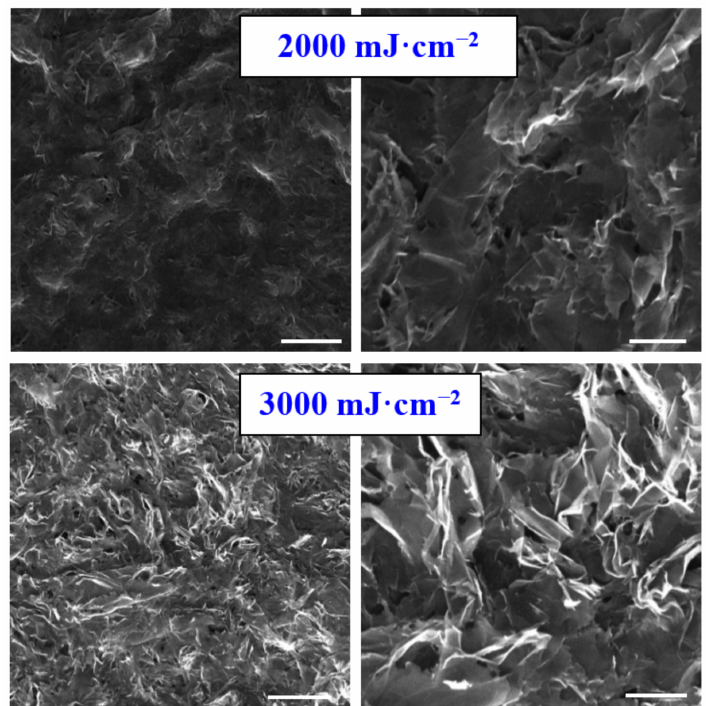
Figure 1. Scanning electron microscopy images of carbon sheet exposed with high-energy excimer laser and laser fluencies for 2000 and 3000 mJ · cm − 2 . The scanning areas were 10 × 10 µ m 2 ( right col- umn) and 30 × 30 µ m 2 ( left column). White lines represent six microns ( left ) and two microns ( right ).